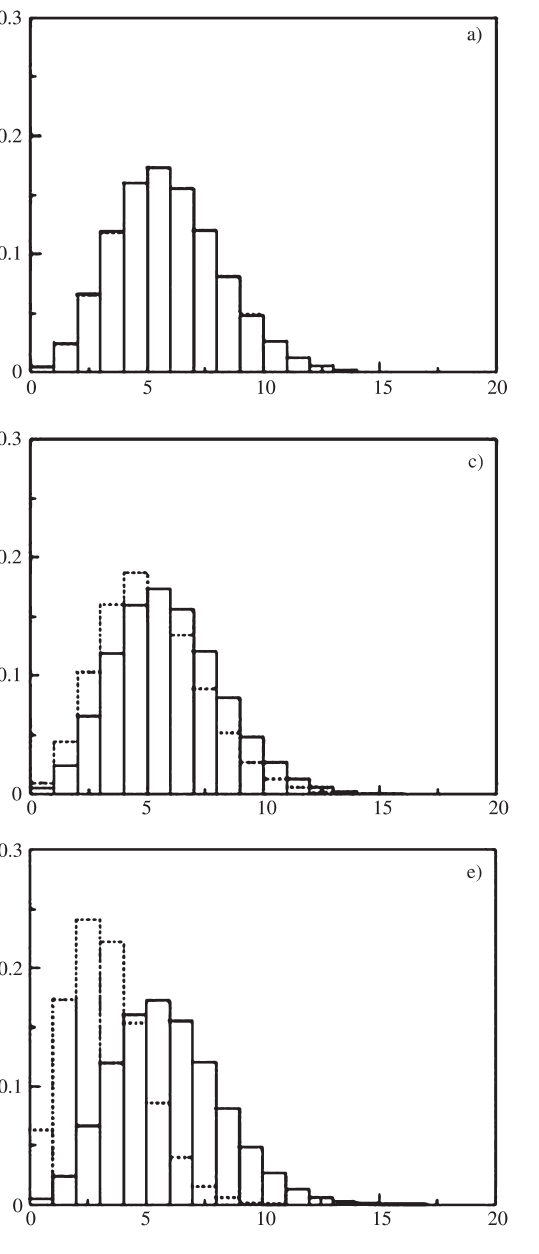
Figure 2 - Histograms of the distribution of branch lengths of generation 840 evolved under the JC model (full line) and the non-reversible model (dotted line) for the four types of ancestors: (a) real ancestor with 50% G+C, (b) ancestor with 55% G+C, (c) ancestor with 65% G+C, (d) ancestor with 75% G+C and(e)ancestorwith100%G+C.Thefrequenciesareaveragedoverthe100setsofsimulationsandnormalizedtothetotalnumberofbranches(8190).